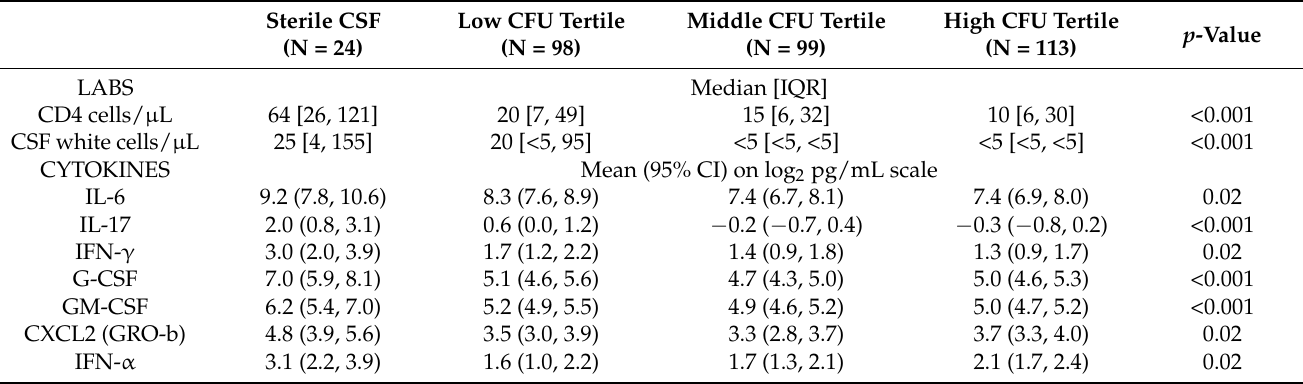
Table 3. CSF biomarkers with more than two-fold difference between those with sterile cultures and those with fungal growth as quantified on baseline